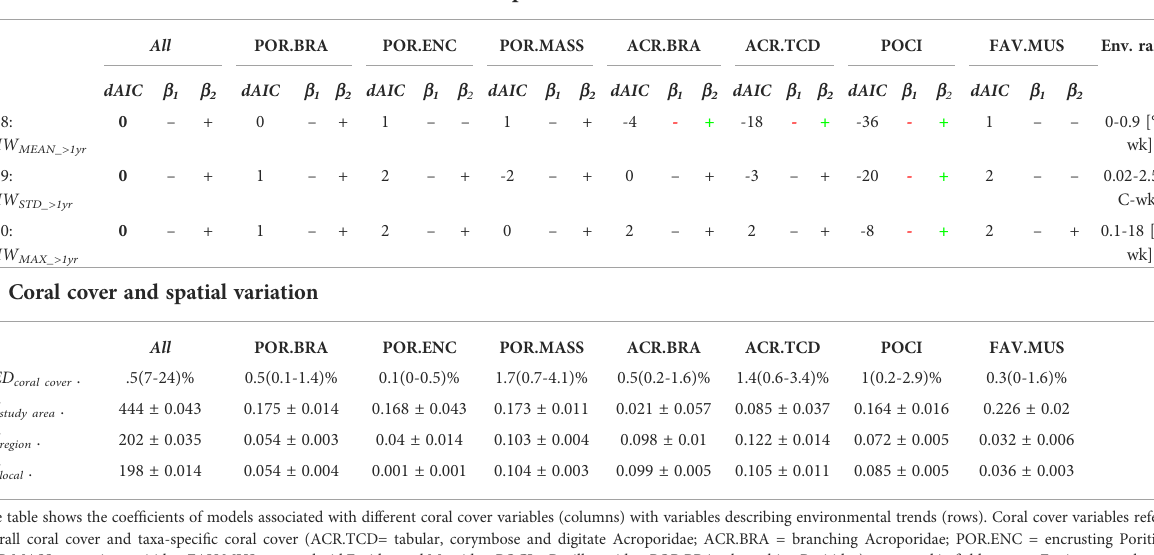
table C), models involve two terms: (1) recent heat stress (maximal DHW measured during the year preceding the survey date) and (2) the interaction between recent heat stress and past heat stress (i.e. DHW statistics measured across all of the previous years). In table D), the median value (showing the interquartile range in parenthesis) of each coral cover variable (MED coral cover ) isshown, together with the coef fi cients ofvariation associated withthe threerandom factorscontrolling for spatialautocorrelation of the survey locations (at a study area- level, CV study area ; at a regional-level, CV region ; at a local-level, CV local dAIC indicates the difference in the Akaike Information Criteria between each model and the null model (i.e. goodness-of- fi tcomparedtothenullmodel).InA)andB), b resp showstheestimatedeffectintheunitscaleofresponsevariable(i.e.thepercentageofabsolutecoralcover;negativeeffectsare inredandpositiveeffectsareingreen).InC), b 1 indicatesthesignoftheeffectofrecentheatstressoncoralcover,and b 2 indicatesthesignoftheeffectoftheinteractionbetweenrecentand past heat stress. Cells in grey indicate models failing to show (1) a stronger goodness-of- fi t when compared to the null model and (2) b signi fi cantly (p<0.01) different from 0. The last column headed ‘ Env. range ’ shows the range of the environmental variable implicated in the association model, with the units indicated in parentheses. The complete list of the coef fi cients and statistics describing the association models are displayed in the Supplementary Table